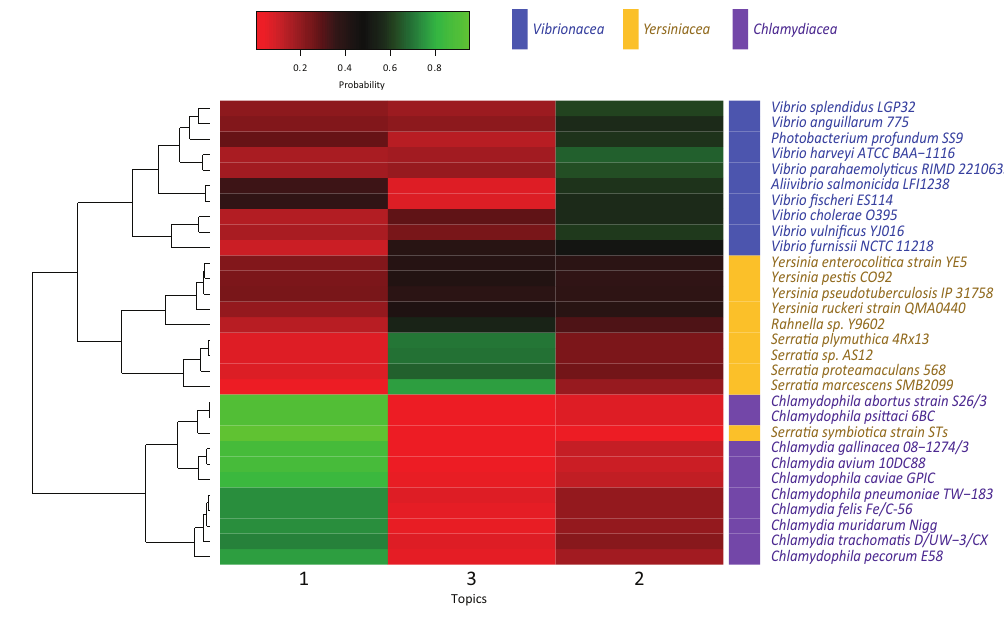
Figure 3. Phylogenomic classification of bacterial families Chlamydiales , Vibrionaceae , and Yersiniaceae based on topic modeling (In this work, three